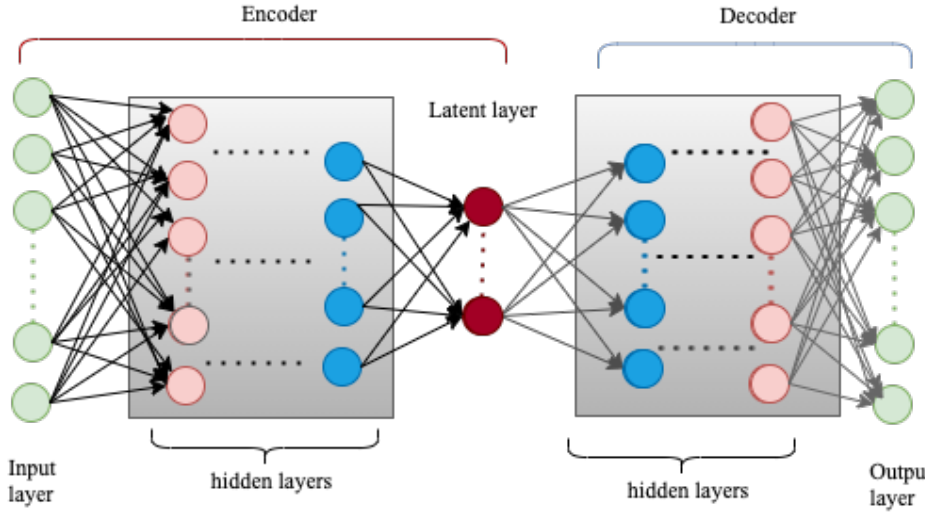
Figure 6. A Deep Autoencoder